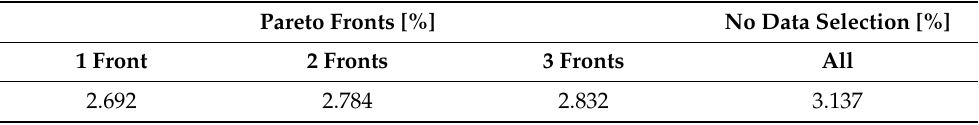
Table 16. MAPE values for Pareto fronts and ‘no data selection’ models for the three-dimensional verification